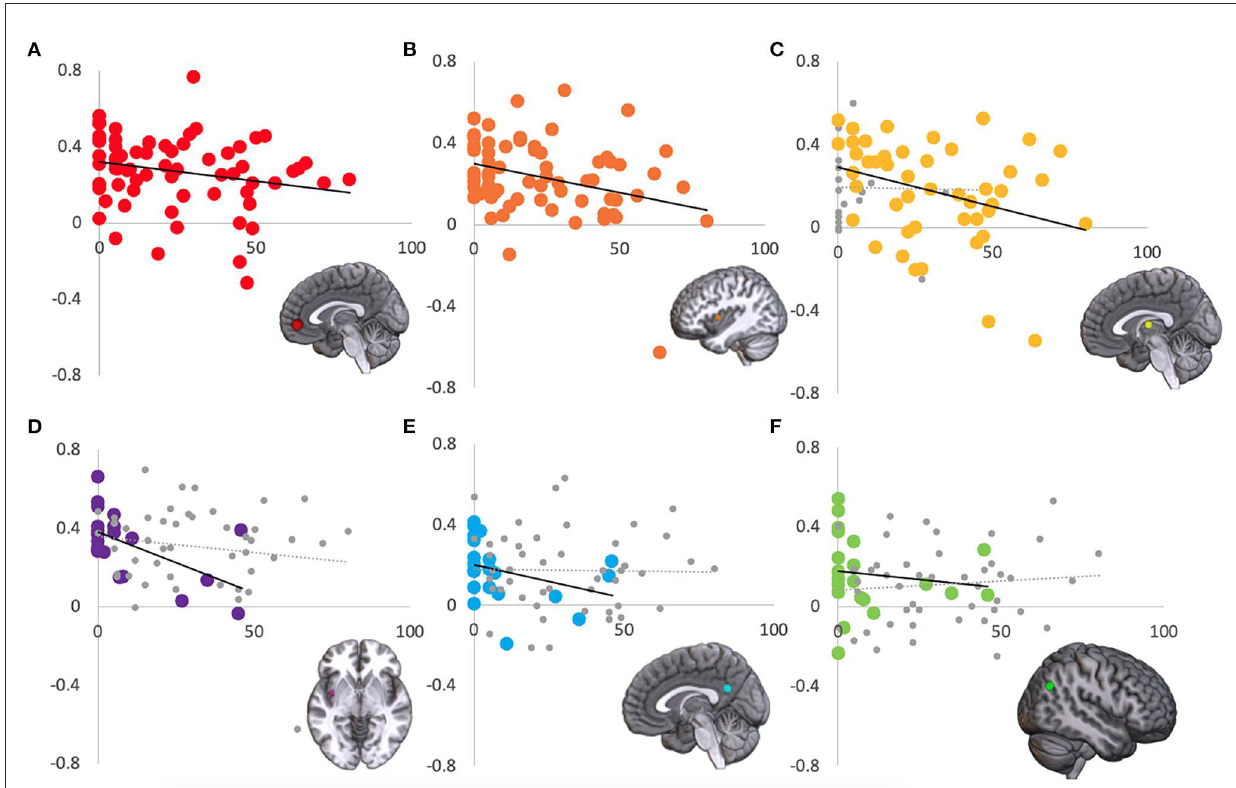
FIGURE7 Regions where connectivity with amygdala is associated with PCL-5 score. Amygdala resting state correlation (y-axis) with six regions was significantly correlated with PCL-5 score (x-axis). Across the entire sample, right amygdala correlation with (A) medial prefrontal cortex and (B) left insula were modulated by PCL-5 score. In the mTBI group, right amygdala and medial dorsal thalamus activity was correlated with PCL-5 score (C) . In the TBI- group, right amygdala correlation with (D) left posterior insula and (E) posterior cingulate, and left amygdala correlation with (F) right lateral parietal lobe were modulated by PCL-5 score. For display purposes, the non-significant group is shown in gray (C–F) .